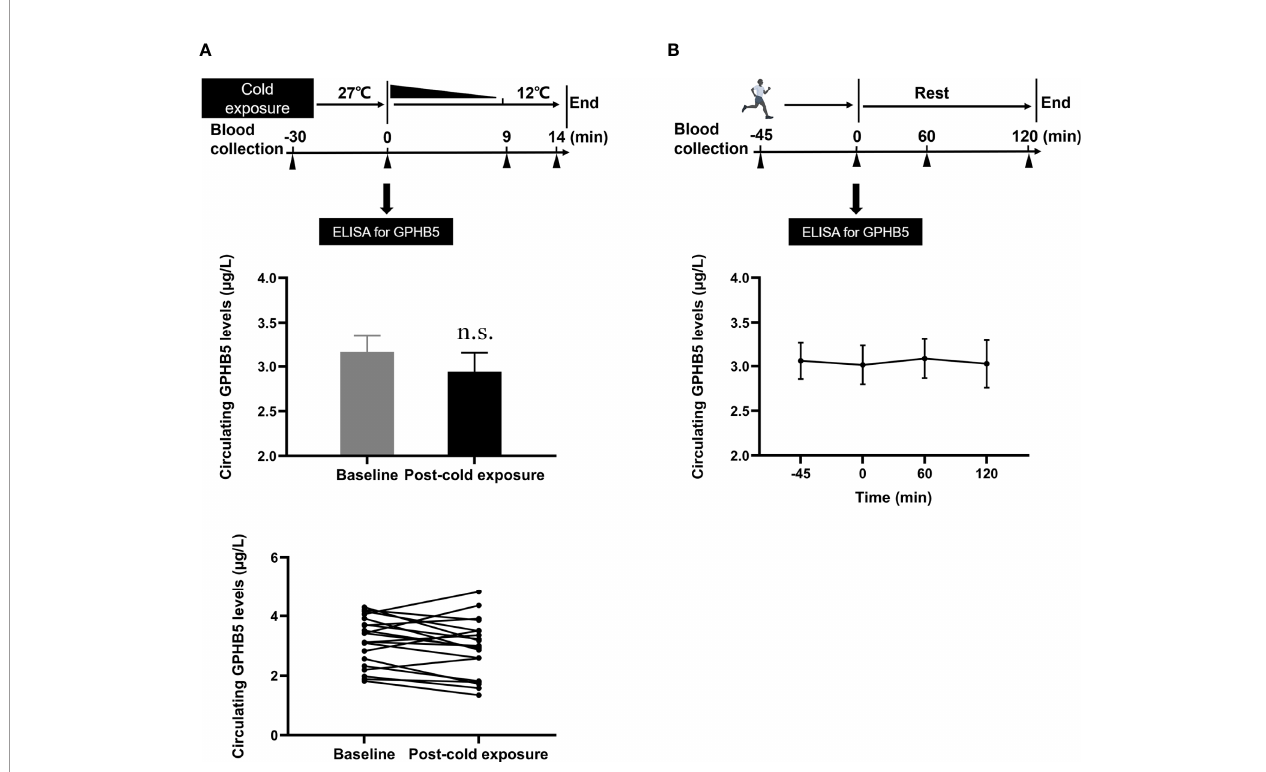
FIGURE 5 | Circulating GPHB5 levels of physical activity and cold-exposure in healthy individuals. (A) Cold-exposure experimental design and circulating GPHB5 levels before and after cold-exposure. (B) Physical activity experimental design and circulating GPHB5 levels before and after exercise. Data are means ± SD. n.s., no signi fi cance; p > 0.05 vs. Baseline